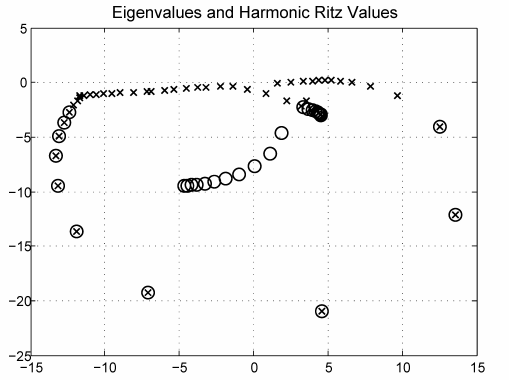
Figure 5: The first 30 eigenvalues of the system matrix with the smallest imaginary part (circles) and the first 50 har- monic Ritz values (crosses) for the golden strip problem.